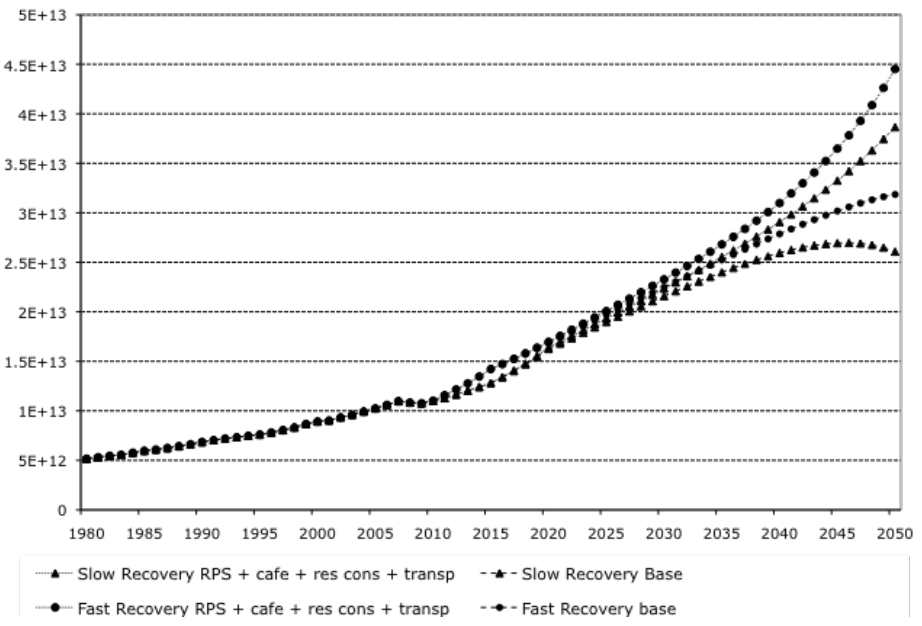
Figure 1. Results of the simulation of T21-USA, Real GDP (USD 2000/year). RPS = renewable portfolio standard; CAFE = corporate average fuel economy; RES CONS = residential energy conservation; TRANSP = electrified